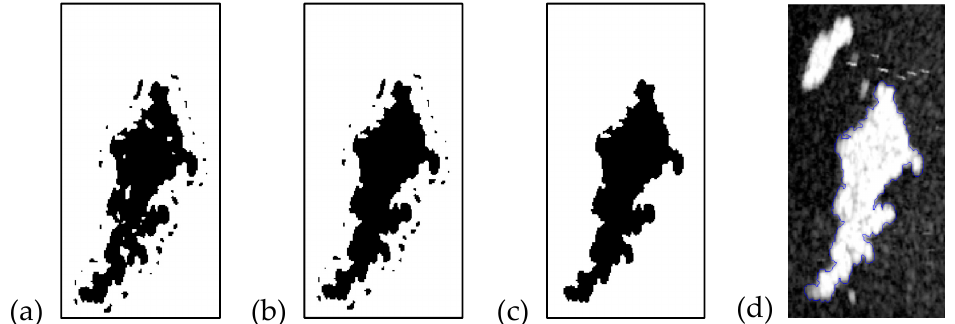
Figure 13. Pixel area threshold method applied to Figure 12d. ( a ) Initial recognition result; ( b ) deleted interference outside the contour T out = 50; ( c ) deleted interference outside the contour T in = 30; and ( d ) the final contour.